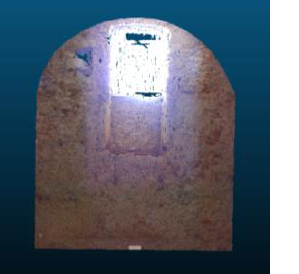
Figure 9 . TLS cloud point Figure 10 . CRP cloud point